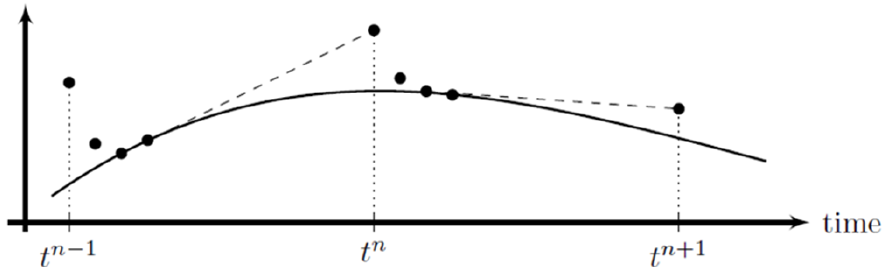
Figure 2. Projective integration: an explicit method is applied over small time steps (black dots) to stably integrate fast modes, then the solution is extrapolated using a much larger time step (dashed lines), modified from